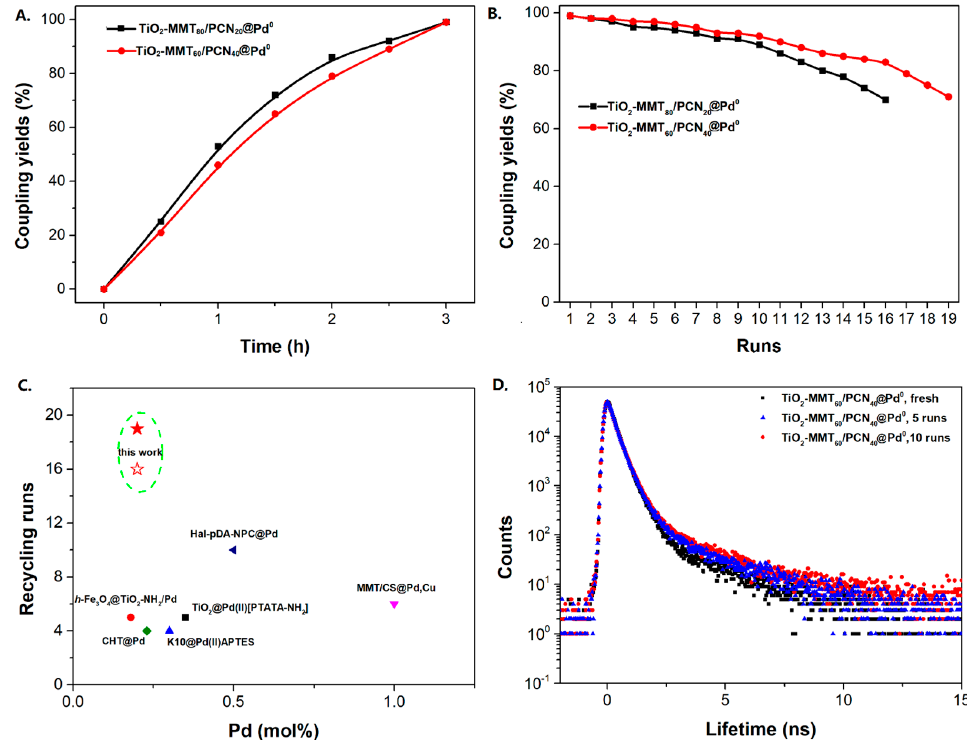
Figure 8. Recycling stabilities of the TiO 2 -MMT/PCN@Pd 0 nanocomposites: ( A ) Coupling yields vs time; ( B ) Coupling yields vs recycling runs; ( C ) Comparing with recently developed catalysts; ( D ) Microstructure changes of the catalyst tracked using PALS determination.